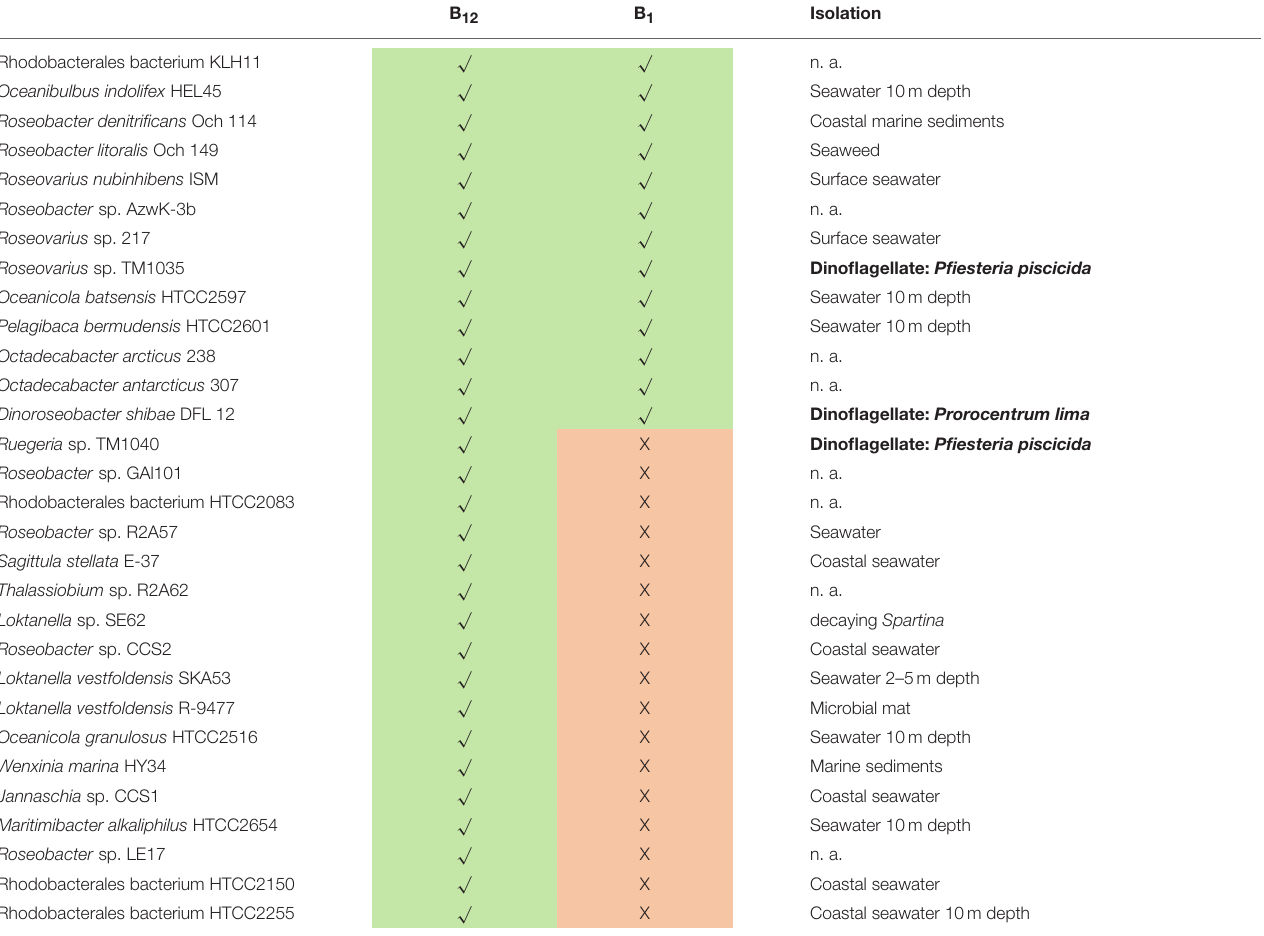
TABLE 4 | Select genes for B-vitamin biosynthesis in 30 B 7 auxotroph Roseobacter isolate